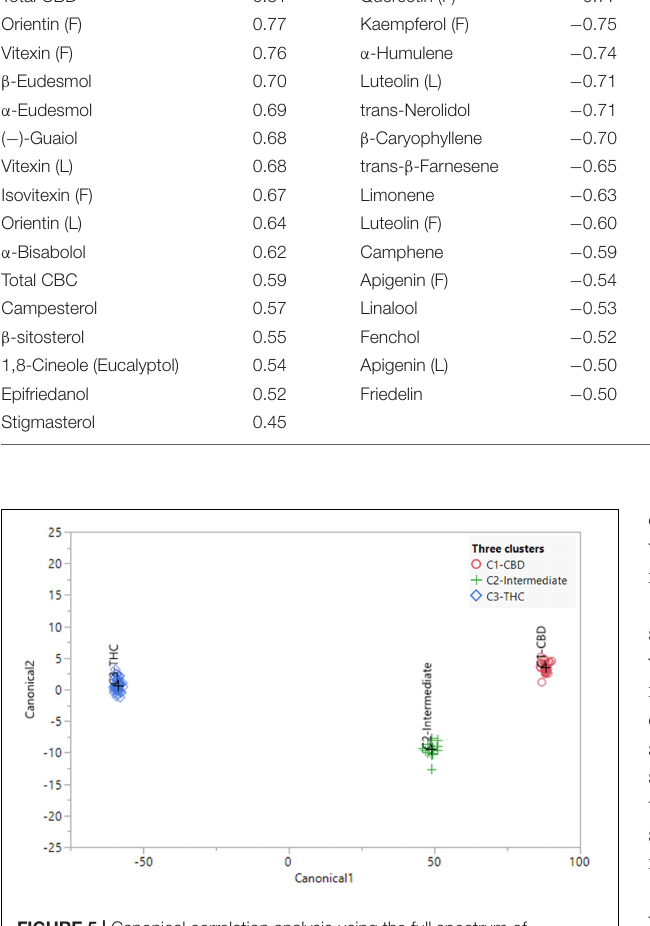
FIGURE 5 | Canonical correlation analysis using the full spectrum of secondary metabolites (using ratios) of 82 plants representing 21 strains. The plants were preassigned to three chemotypes in Table 1 . The observations and the multivariate means of each group (“+”) are represented as points on the biplot. An ellipse denoting a 50% contour is plotted for each group, that contains approximately 50% of the